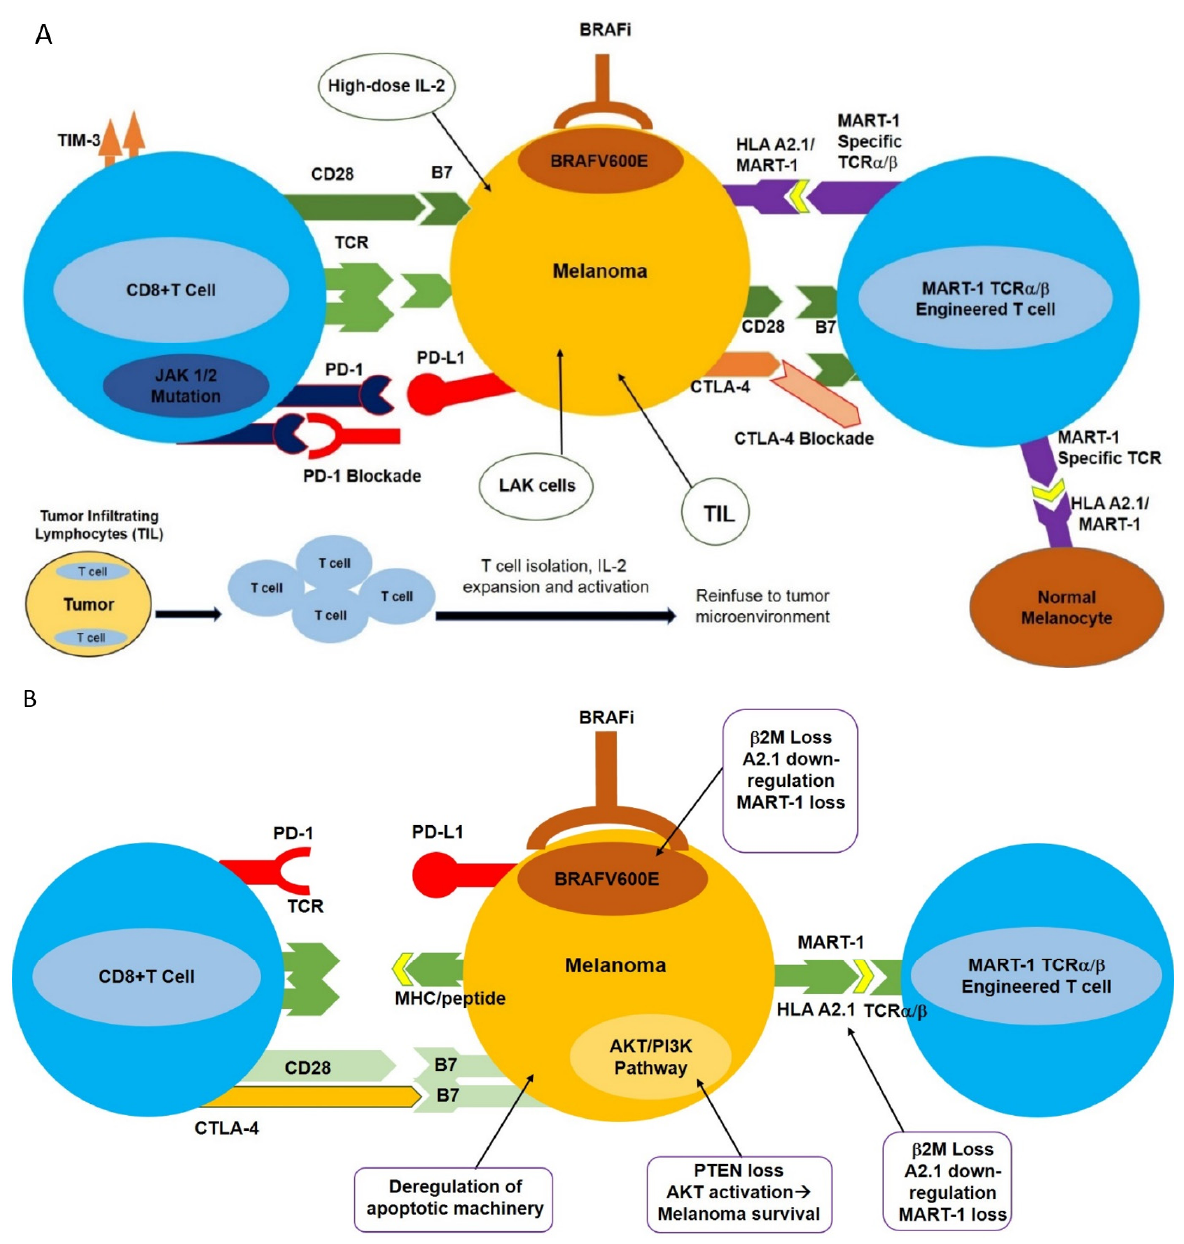
Figure 1. Potential immune-based treatment options for the treatment of metastatic melanoma. ( A ) Various immune-based treatment options are available to treat patients harboring metastatic melanoma, including high-dose IL-2, tumor-infiltrating lymphocytes (TIL), lymphokine-activated killer cells (LAK), and TCR-transgenic T cells directed against specific melanoma-associated antigens such as MART-1. More recently, immune checkpoint blockade using antagonistic monoclonal antibodies directed against PD-1 and CTLA-4, as well as specific molecular targeting of BRAF V600E , have been employed. These strategies have had varying degrees of success in the treatment of metastatic melanoma. ( B ) Potential mechanisms of melanoma resistance to T cell-based therapy. Various inherent (primary) or acquired (secondary) mechanisms have been implicated in the resistance of melanoma to T cell-based therapies. These resistance mechanisms may include deregulation of apoptotic machinery, favoring an anti-apoptotic phenotype to melanomas, loss of PTEN, and constitutive activation of the AKT signaling transduction pathway, leading to melanoma survival. Loss of the β 2M component HAL A2.1, downregulation (internalization) or shedding of the MHC complex, or loss of TAA (such as MART-1) will render melanomas unrecognized by T cells. For additional information, refer to the text.